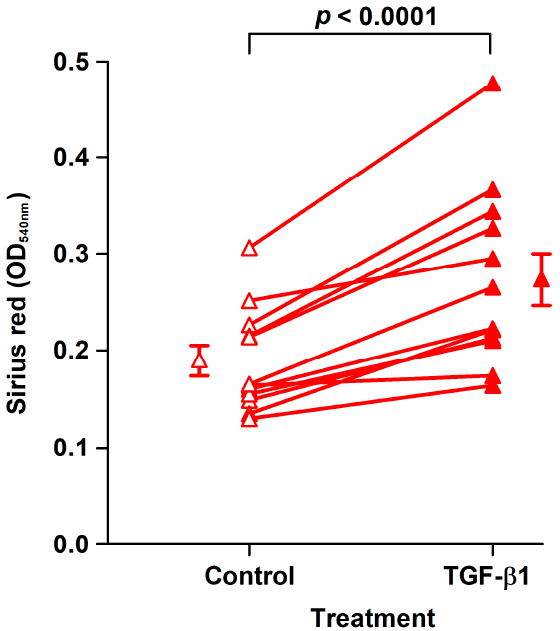
Figure 4. TGF- β 1 treatment (closed triangles, OD 540nm : 0.27 ± 0.027/well) of CoReFs for 8 days increased collagen deposition compared to the control (open triangles, OD 540nm : 0.19 ± 0.015/well), as measured by Sirius red staining. An OD 540nm value of 0.20 corresponds to 20 µg type I collagen. Mean ± SEM ( n = 12).